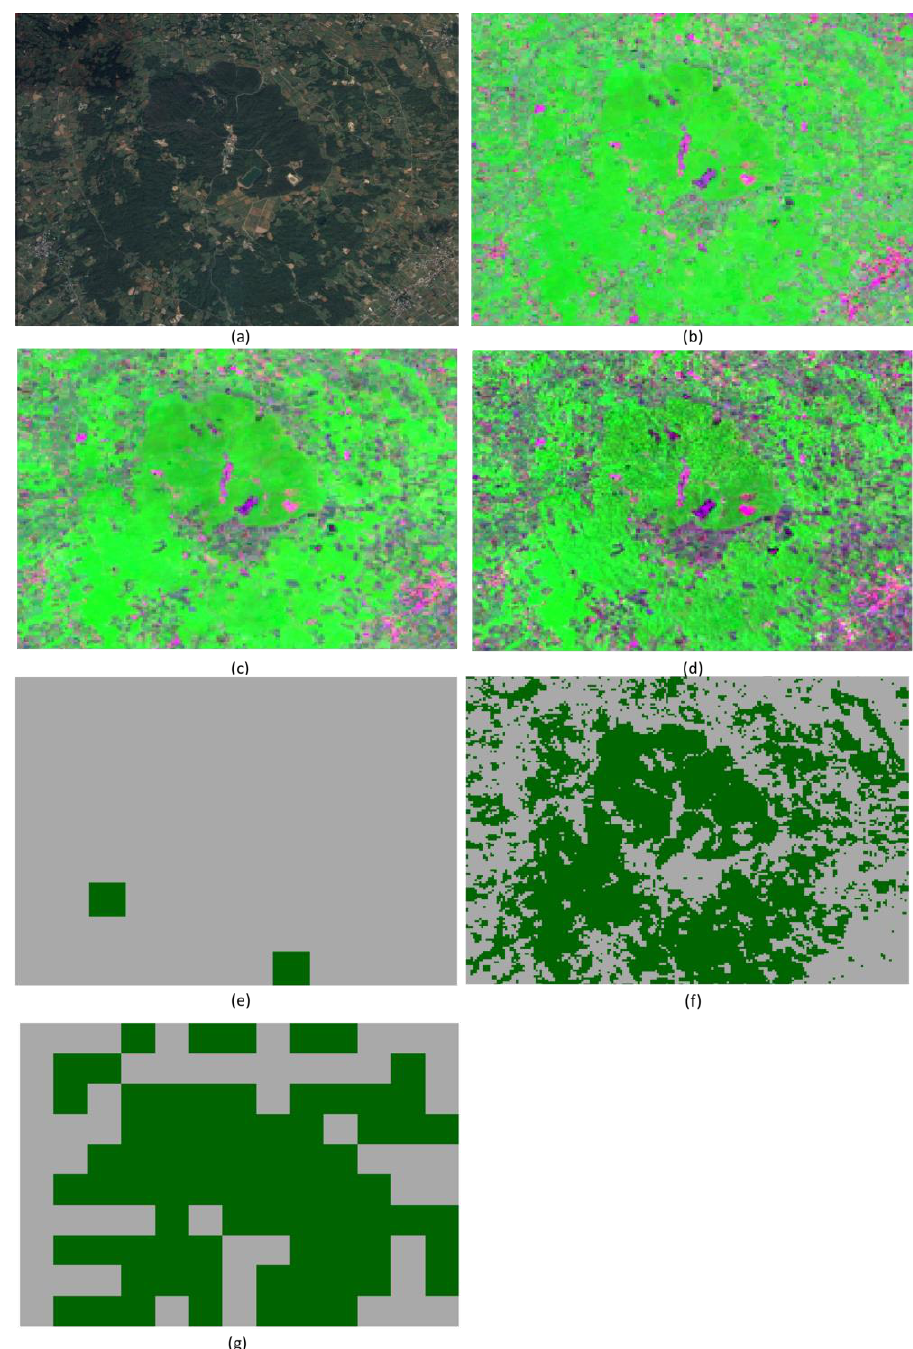
Figure 4. An example demonstrating the performance of the image composites for the detection of forested areas. ( a ) Google Earth true-color imagery dated 31 December 2016 provided by Google, DigitalGlobe; ( b ) 30-m resolution Biophysical Image Composite (BIC); ( c ) 30-m resolution Forest Cover Composite (FCC); ( d ) 30-m resolution Enhanced Forest Cover Composite (EFCC); ( e ) 500-m resolution MCD12Q1 product-based extraction of forested (green pixels) and non-forested (gray pixels) areas; ( f ) newly produced map (30 m)-based extraction of forested (green pixels) and non-forested (gray pixels) areas; ( g ) newly produced map resampled into a resolution of 500 m.